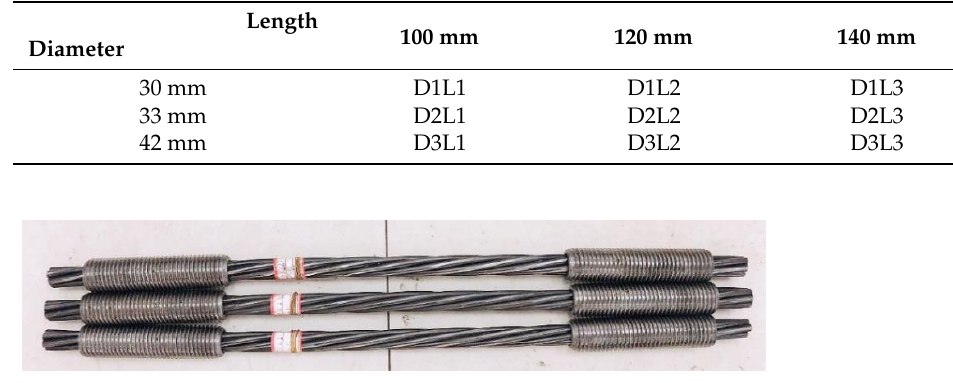
Figure 3. Length measurement of locking casing. Table 1. Serial number of flexible bolts.